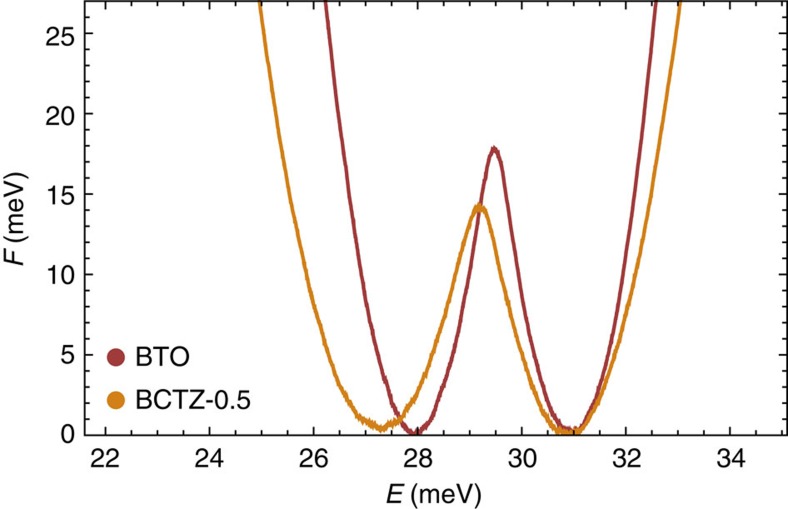
Free-energy landscape.Free-energy-like quantity versus internal energy (in meV per 5-atom cell) for (1−x)Ba(Zr0.2Ti0.8)O3−x(Ba0.7Ca0.3)TiO3 with x=0.50 (BCTZ-0.5) in yellow, and BaTiO3 (BTO) in red, at their P4mm–Amm2 transition temperatures (which are 297 and 283 K, respectively). Results correspond to the use of a 18 × 18 × 18 supercell. This free-energy-like quantity is the logarithm of the normalized canonical distribution28.